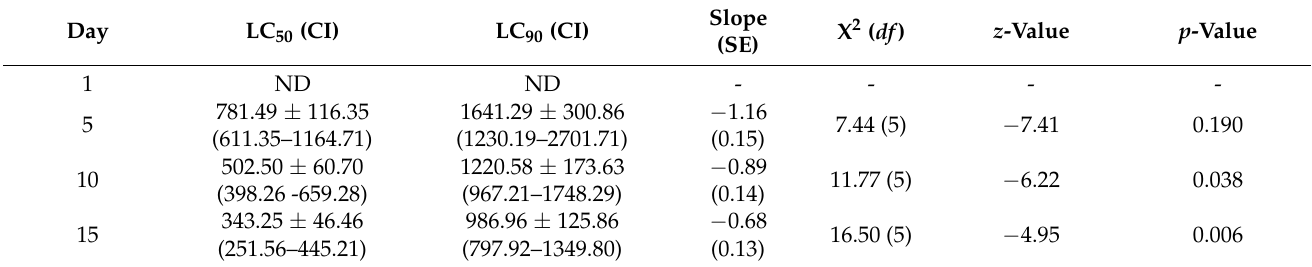
Table 5. Lethal concentrations and regression analysis of Sitophilus zeamais adults treated with Schinus molle essential oil.